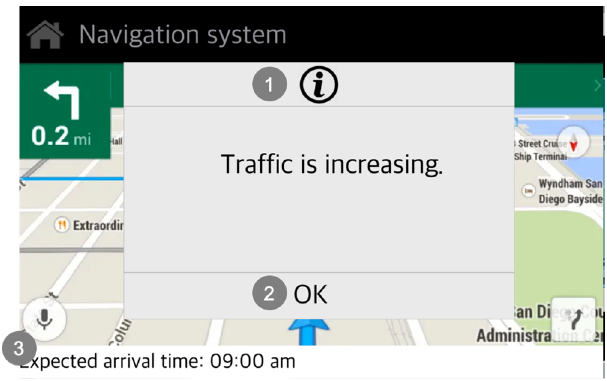
Figure 8. Descriptions of the pop-up screen of the current telematics system (Source: Own creation): ( 1 ) Through a pop-up, the telematics system informs the traffic info, however, it does not present information about the accident that occurred ahead, but only the part of the situation information presented. ( 2 ) It only supports a limited interaction by using a button; and ( 3 ) It does not support direct perception regarding the remaining time; the driver needs to calculate as the change of expected arrival time (No direct perception supported).